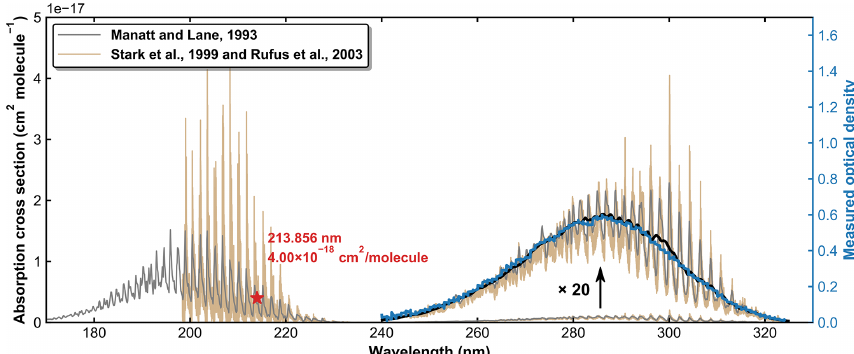
Figure 1. SO 2 absorption spectra reported by Manatt and Lane (1993) and Stark et al. (1999; Rufus et al., 2003). The black line is the result of degrading the resolution in the 240–325nm region to that of our optical density measurements (blue line).